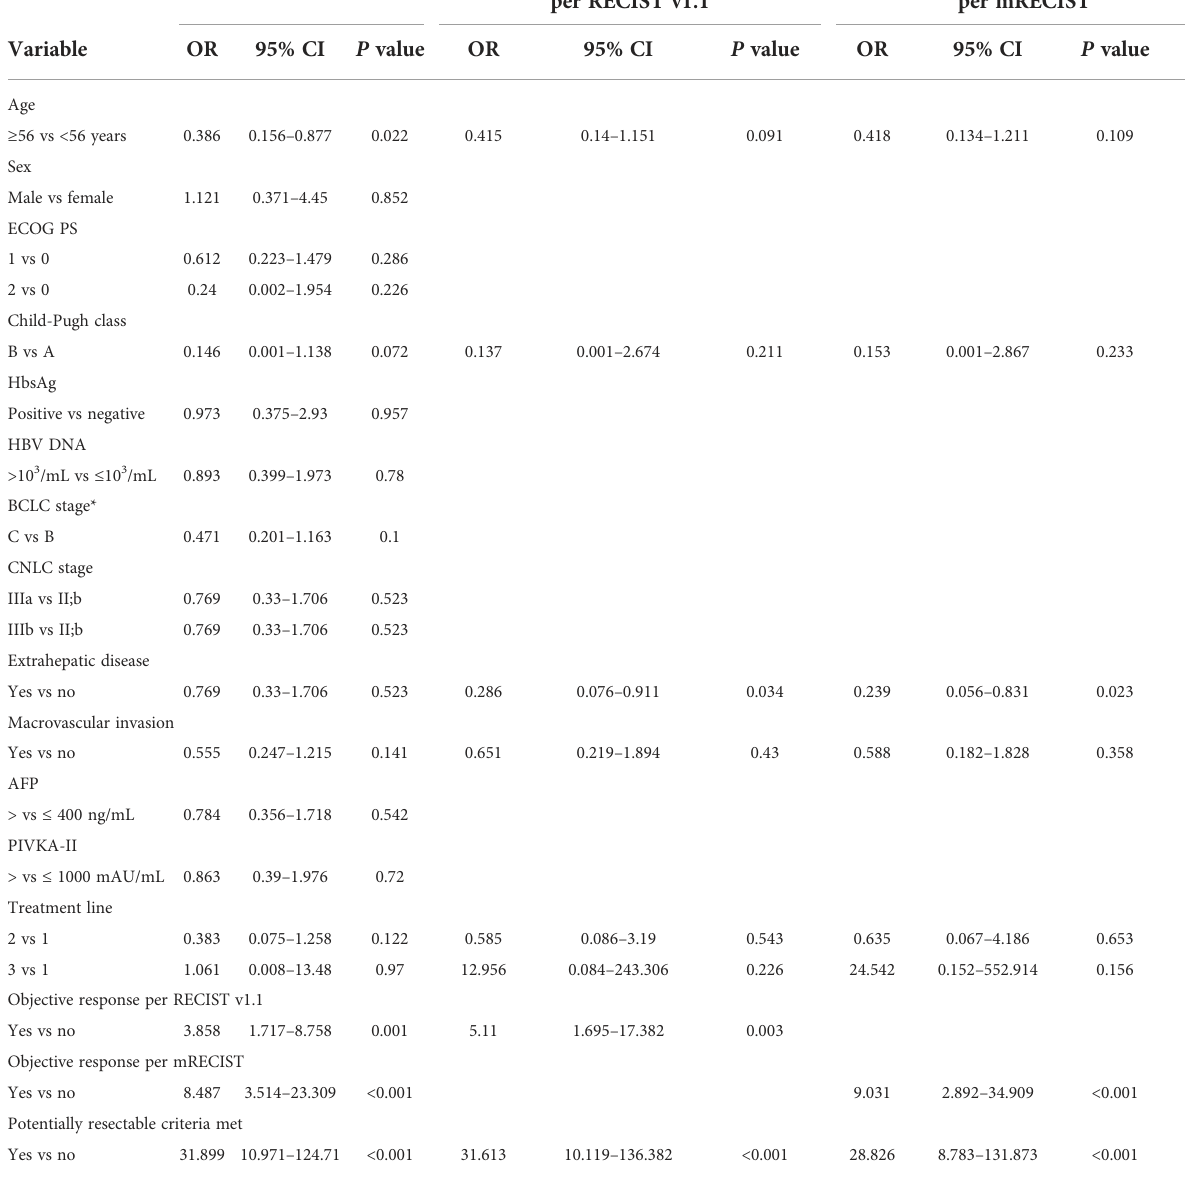
TABLE 5 Univariate and multivariate Firth logistic regression analysis for predictors of surgery. Univariate analysis Multivariate analysisincluding response per RECIST